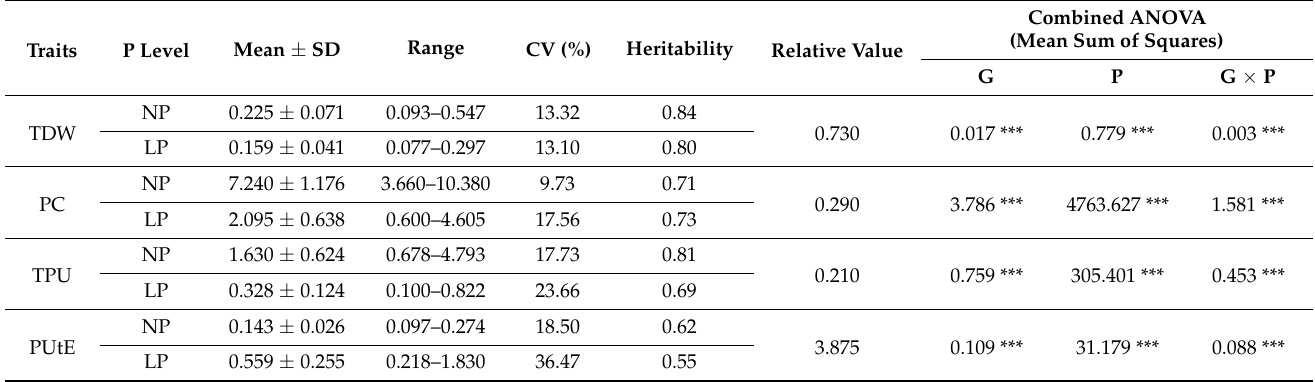
Table 1. Descriptive statistics of total dry weight, P concentration, total P uptake, and P utilization efficiency of mungbean under two P conditions.